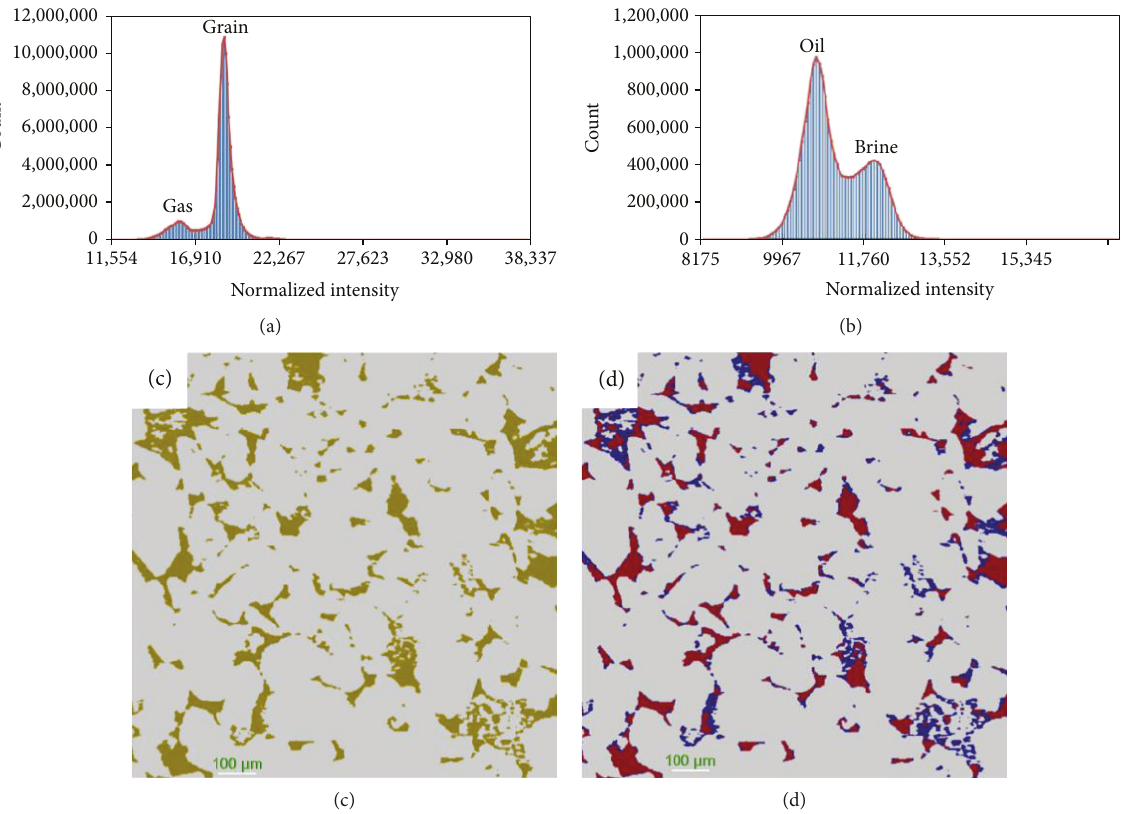
Figure 4: Images segmentation results: (a) intensity of gas and grain; (b) intensity of oil and brine; (c) pore-throat network and rock matrix; (d) oil and irreducible water. Note: yellow =pore-throat; gray=rock particles; blue=irreducible water; red